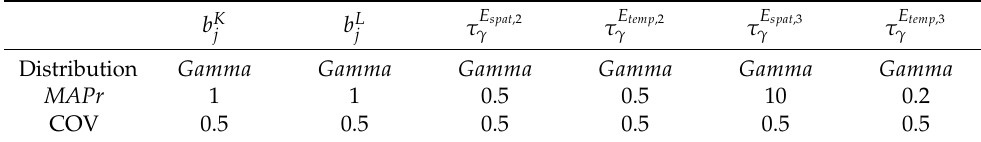
Table 1. Prior PDF of parameters.